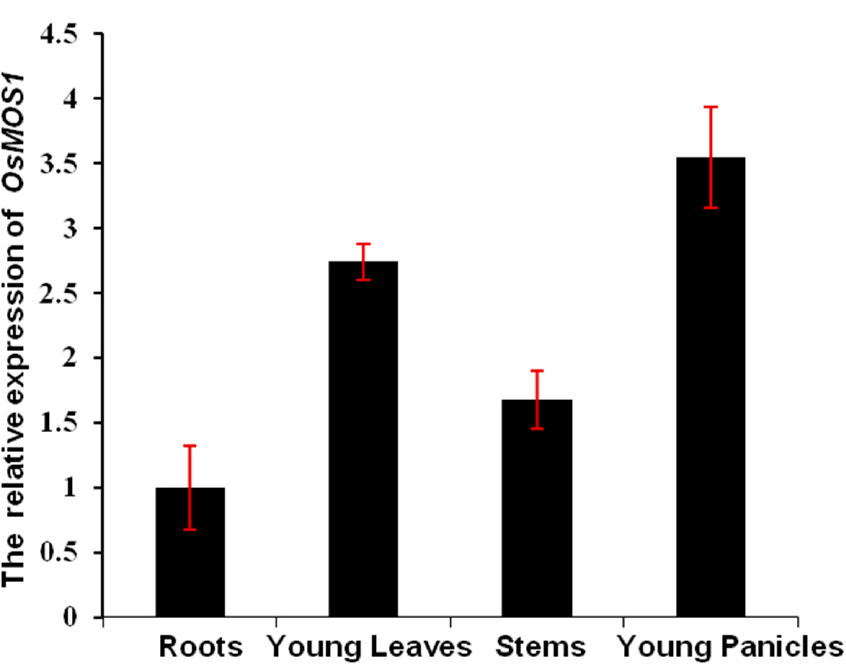
Figure 2. Expression profiles of OsMOS1 . Relative expression levels of OsMOS1 in different rice tissues of NIP checked by qPCR. The rice ACTIN gene was used as the internal control. Error bars indicate the standard deviation, n = 3.